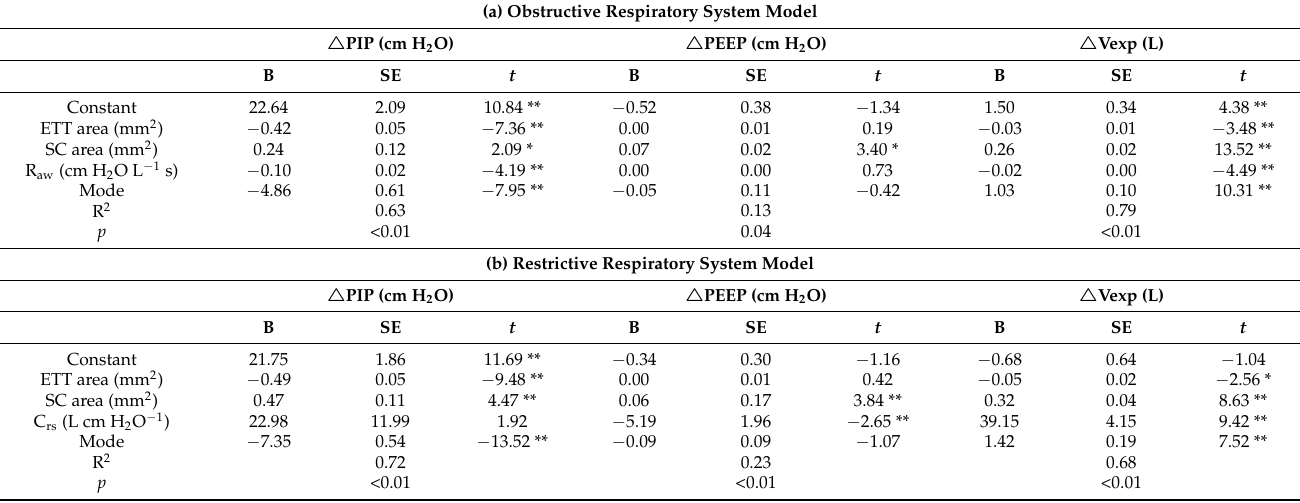
Table 2. Multiple regression analysis of factors affecting closed endotracheal suctioning: ( a ) Ventilator-related parameters of factors affecting the obstructive respiratory system; ( b ) Ventilator-related parameters of factors affecting the restrictive respiratory